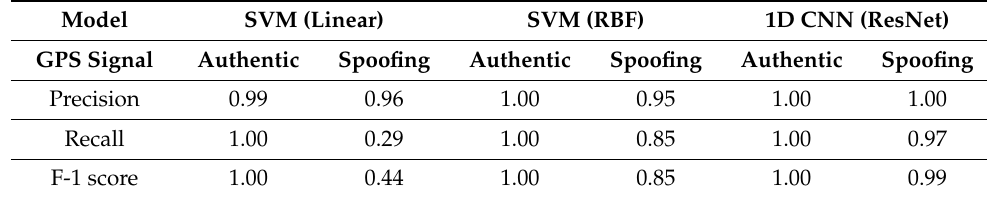
Table 6. Performance comparison with machine learning